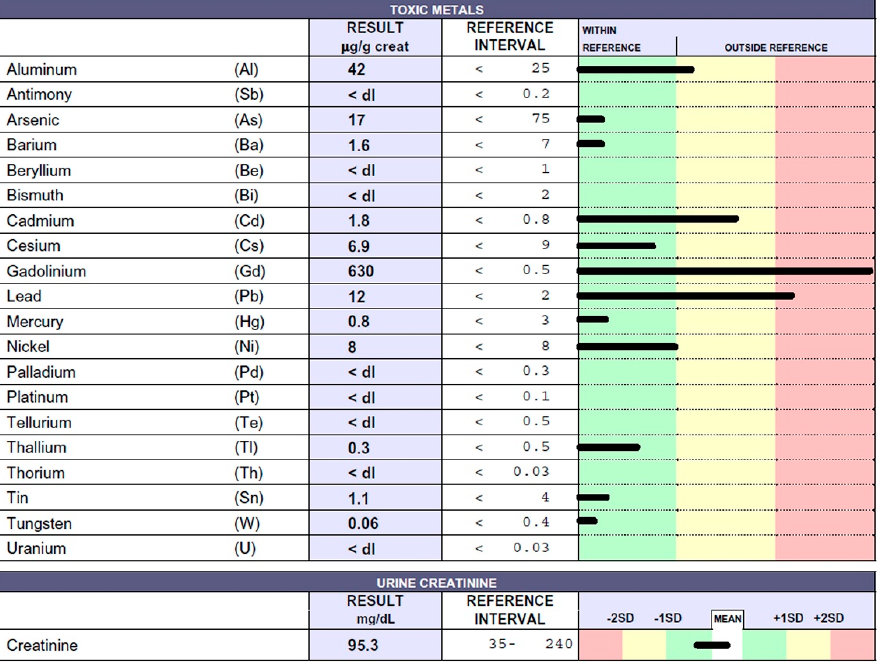
Figure 3. Toxic metal levels measured by ICP-MS method in the patient’s urine collected during the 12 h following EDTA chelation test reported in micrograms (µg) per g creatinine. The 34-year-old man was affected by multiple sclerosis (MS).